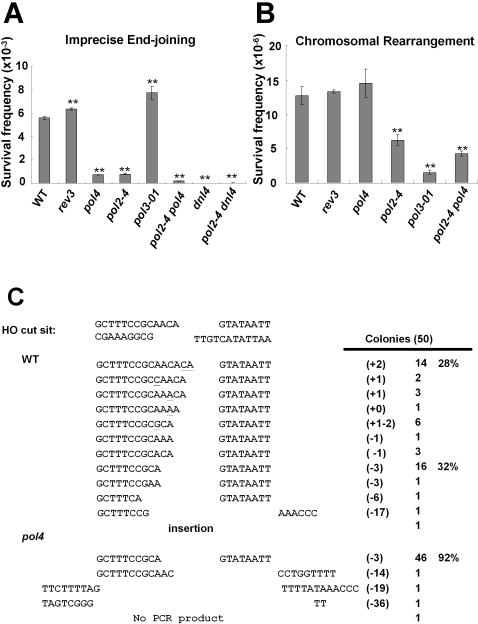
Measurements of NHEJ ability of non-essential DNA polymerases.The efficiency of NHEJ of wild-type and polymerase defective mutants, rev3, pol4 and 3′ to 5′ exonuclease defective mutants, pol2-4, pol3-01, pol2-4 pol4, dnl4, and pol2-4 dnl4 were measured. (A) Frequencies of imprecise end joining. The survival frequency was evaluated by the ratio of YPGal/YPD. (B) Frequency of chromosomal rearrangement was evaluated by the ratio of FOAR/YPD. Each experiment was collected from at least four independent clones. *: P<0.05; **: P<0.01. (C) The sequence analysis of the imprecise end joining events from the WT and pol4 mutants. The structures of various imprecise end joining repairs were identified at the DSB site. Sequences of the HO cut site are shown, with the resulting 3′ overhanging terminal AACA shown on the cut site. Samples of independent joints were PCR amplified and sequenced. A total of 50 independent survivors on YPGal plates from WT and pol4 mutant were examined. Bases underlined indicate insertion or mutation. The numbers of inserted (+) and deleted (−) bases were denoted in brackets. N indicates the events of each repair pattern.